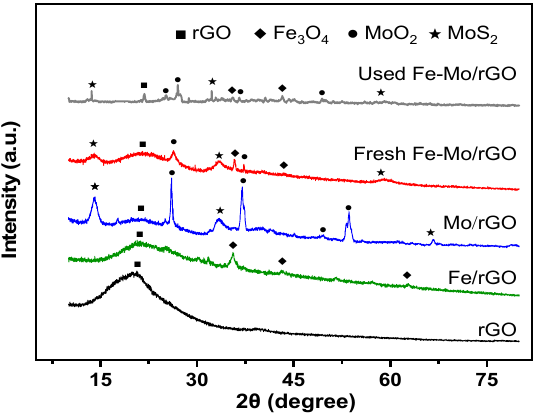
Figure 2. XRD patterns of different catalysts. The XPS full scan spectrum showed that Fe, Mo, O, S, and C elements were successfully loaded in the Fe-Mo/rGO catalyst (in Figure 3a), in correspondence with the result of EDS mappings of the catalyst. In Figure 3b, the broad XPS spectrum of the catalyst showed two characteristic peaks at 710.5 and 725.5 eV were attributed to Fe 2p 3/2 and Fe 2p 1/2 , respectively. The high-resolution Fe XPS peaks were fitted into four peaks, the peaks at 712.7 and 725.5 eV were assigned to Fe(III)-O, and the peaks at 710.5 and 723.1 eV were attributed to Fe(II)-O [18,24]. In Figure 3c, the peaks at 229.1 and 232.2 eV were attributed to Mo(IV)-S, and the peaks at 229.5 and 232.8 eV were corresponded to Mo(IV)-O in the catalyst. Additionally, the peak at 235.1 eV was characterized as Mo(VI)-O. Moreover, a narrow S 2s peak at 226.4 eV also appeared in the Fe-Mo/rGO catalyst. These results indicated that chemical bonds of Mo-S, Mo-O, and Fe-O were formed in the Fe-Mo/rGO catalyst, in agreement with that of XRD [13]. In Figure 3d, the C 1s peak could be assigned to three peaks. In addition to the characteristic peaks of rGO at 285.0 and 288.9eV, a strong binding energy peak at 285.7 eV was attributed to the C-S bond formed during rGO and MoS 2 hybridization. According to the XPS and XRD results, the Fe-O-Mo and Mo-S-C bonding bridges were effectively formed in the Fe-Mo/rGO catalyst.